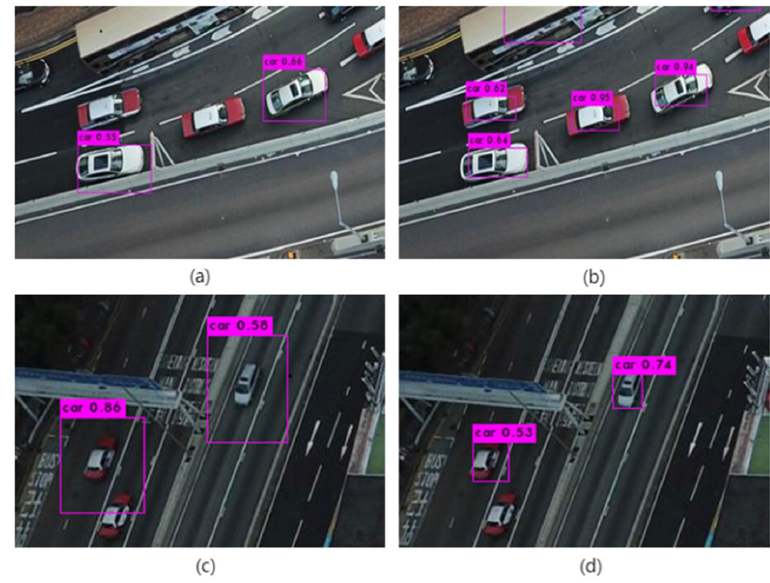
Figure 14. Boundary regression visualization